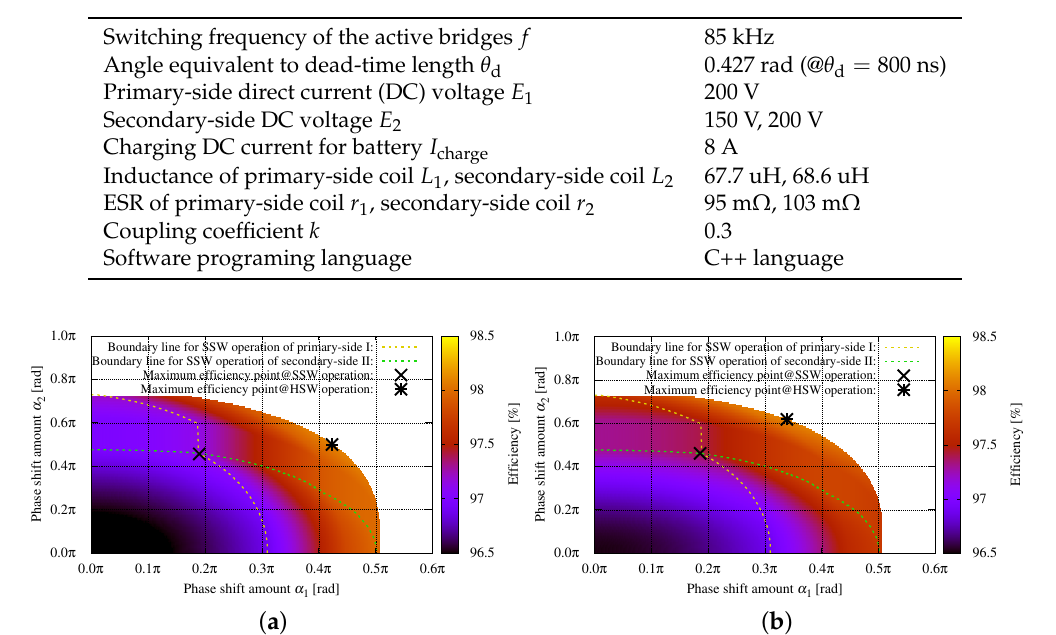
Table 1. Circuit parameters for the analysis.